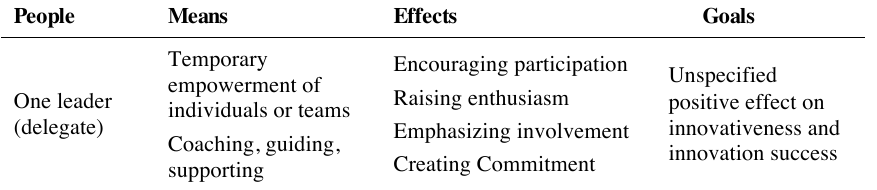
Unspecified positive effect on innovativeness and innovation